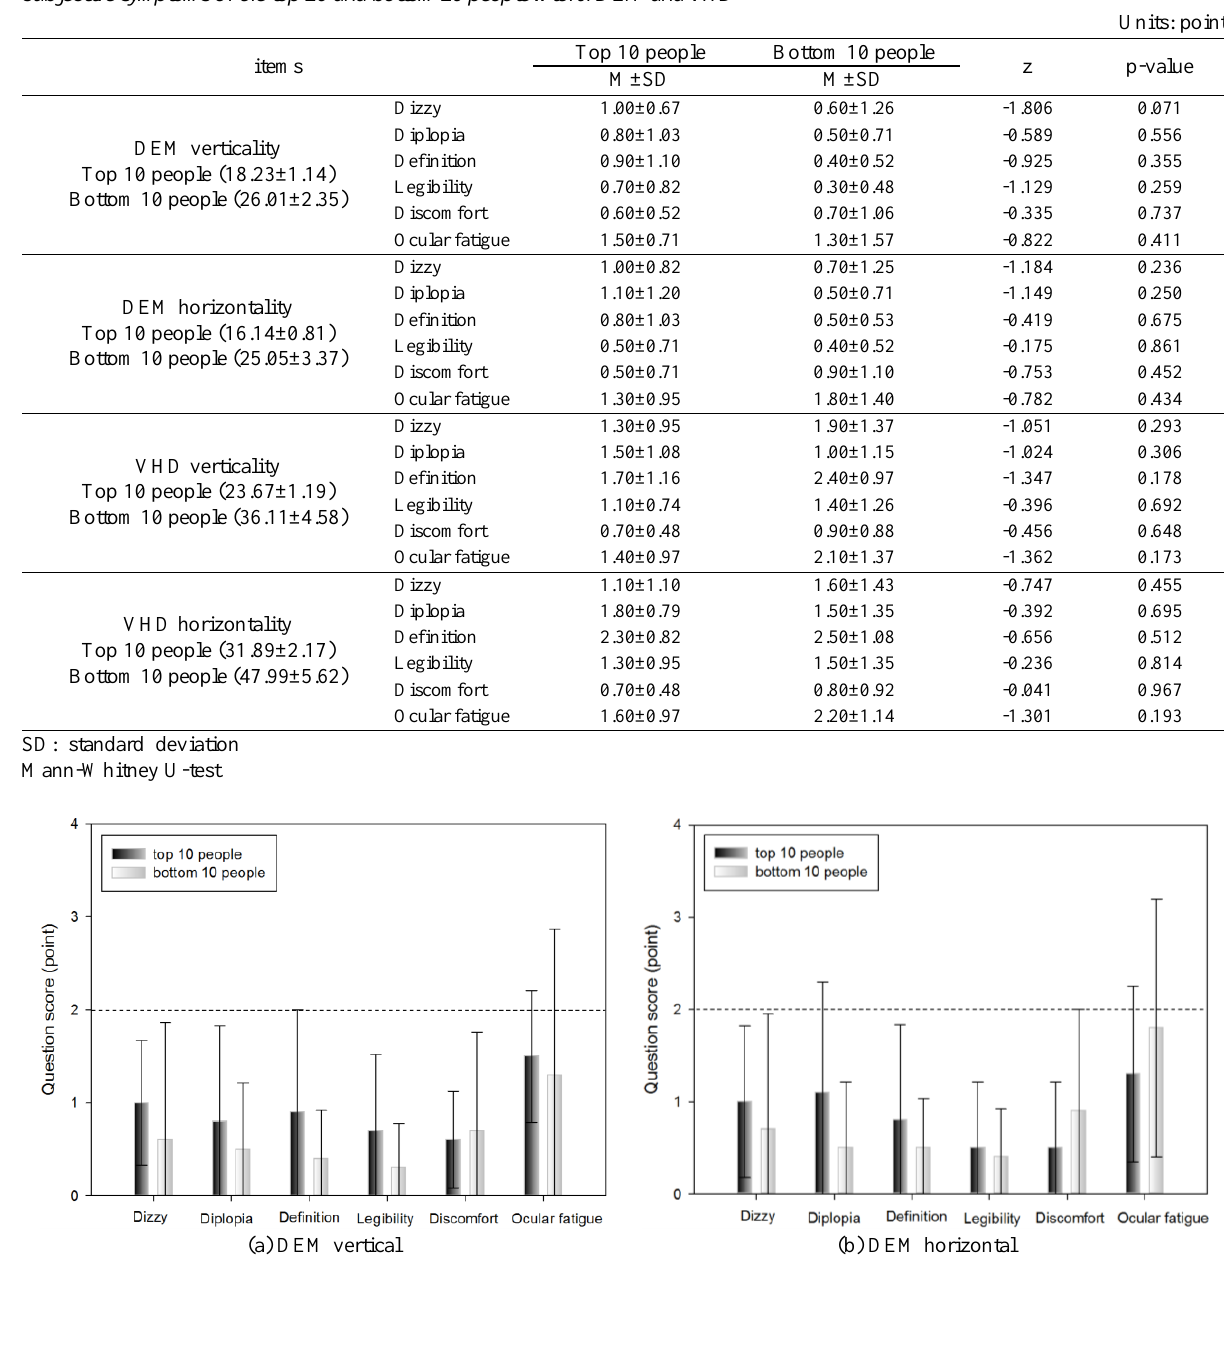
Units: point z p-value